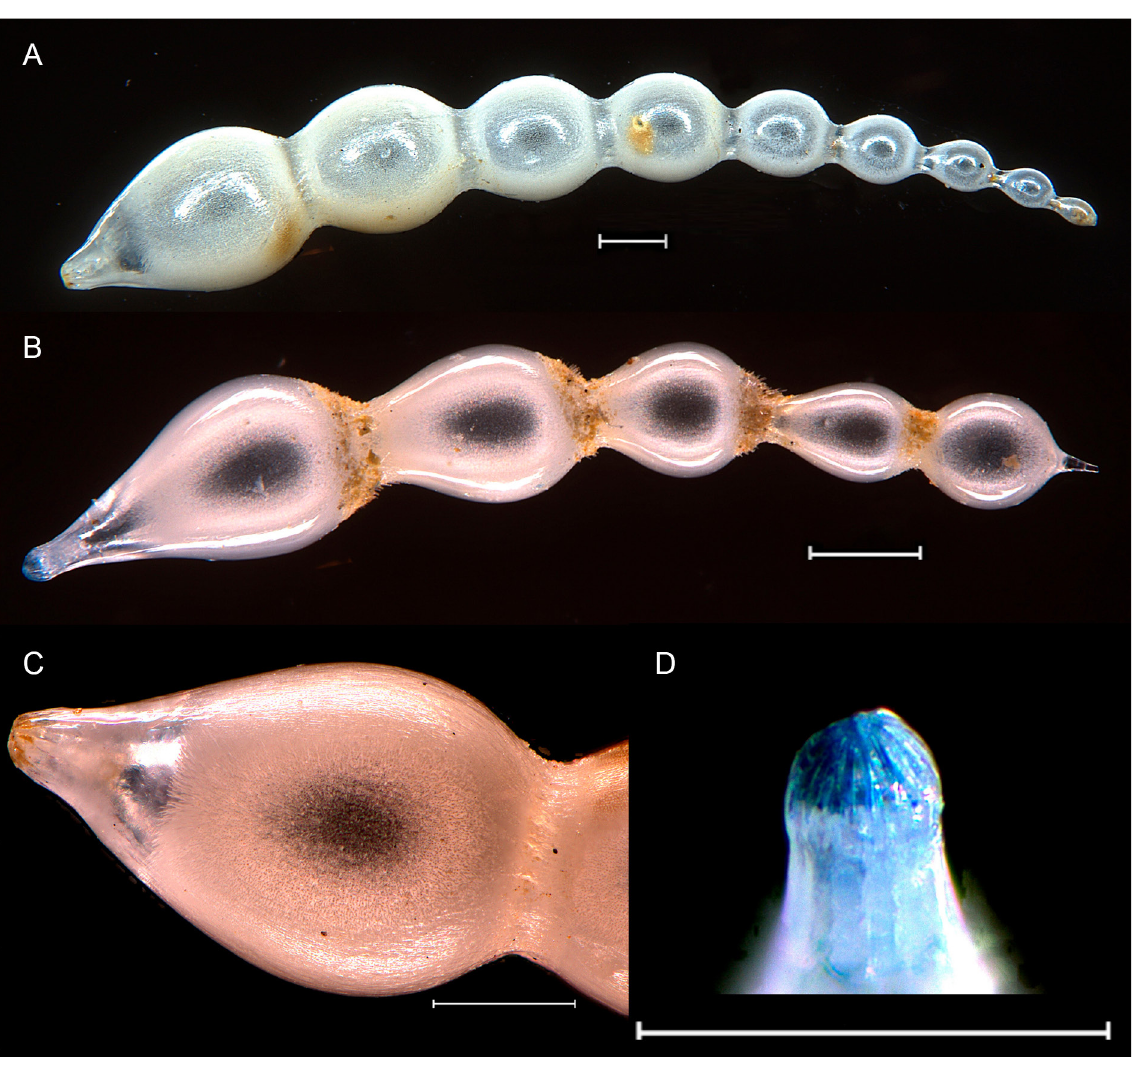
Fig. 10. Grigelis guttifera (d’Orbigny, 1846) comb. nov. A, C . Microsphere with missing initial chambers (BIOICE 2853, IINH 40236a), side view (A) and detail of last chamber (C). B, D . Megalosphere (BIOICE 3264, IINH 40118), side view (B) and aperture (D) stained with indigo blue. Light source combination of incident light and dark field. Scale bars = 0.25